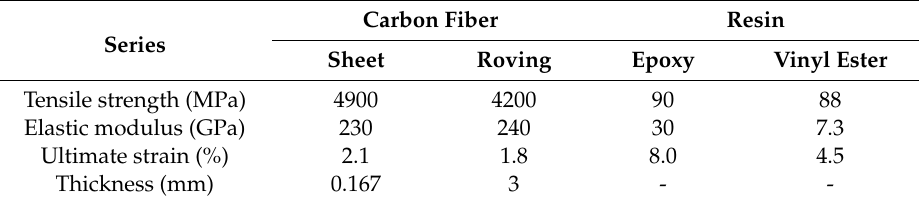
Table 6. Mechanical properties of carbon fiber and resin.